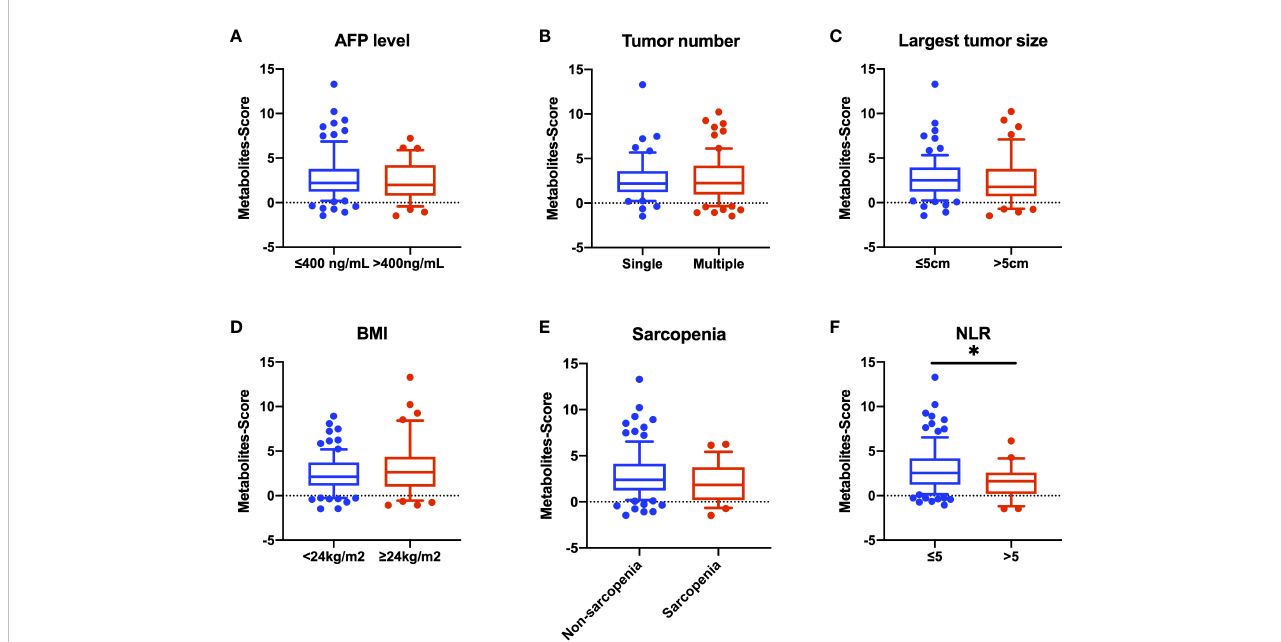
FIGURE 5 Comparison of Metabolites-Score in different groups divided by clinical parameters. Metabolites-Score showed no signi fi cant difference in groups divided by tumor parameters and body nutrition parameters, but was signi fi cantly correlated to NLR level. (A) Bar plot for AFP ≤ 400 ng/mL group vs. >400ng/mL group. (B) Bar plot for single tumor group vs. multiple tumor group. (C) Bar plot for largest tumor size ≤ 5 cm group vs. >5 cm group. (D) Bar plot for BMI<24kg/m2 group vs. ≥ 24kg/m2 group. (E) Bar plot for non-sarcopenia group vs. sarcopenia group. (F) Bar plot for NLR ≤ 5 group vs. >5 group. Data are expressed as median (10-90 percentile range) (*P < 0.05, Mann – Whitney U test).